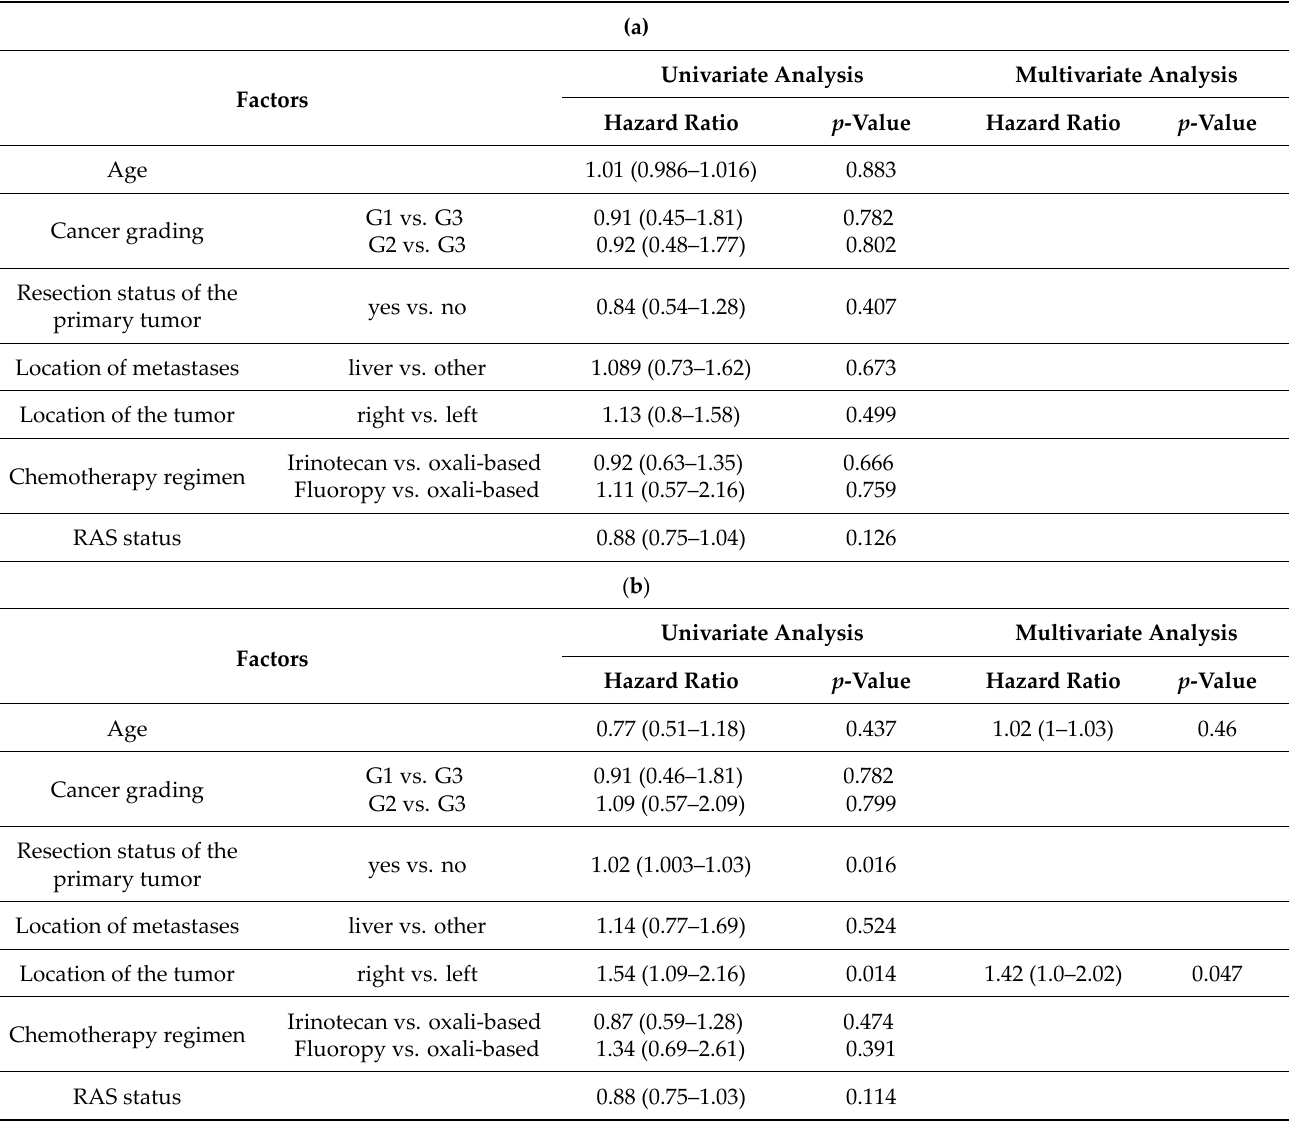
Table 4. ( a ) A univariate and multivariate analysis of the prognostic factors of PFS with bevacizumab in the first line. ( b ) A univariate and multivariate analysis of the prognostic factors of OS with beva‑ cizumab in the first